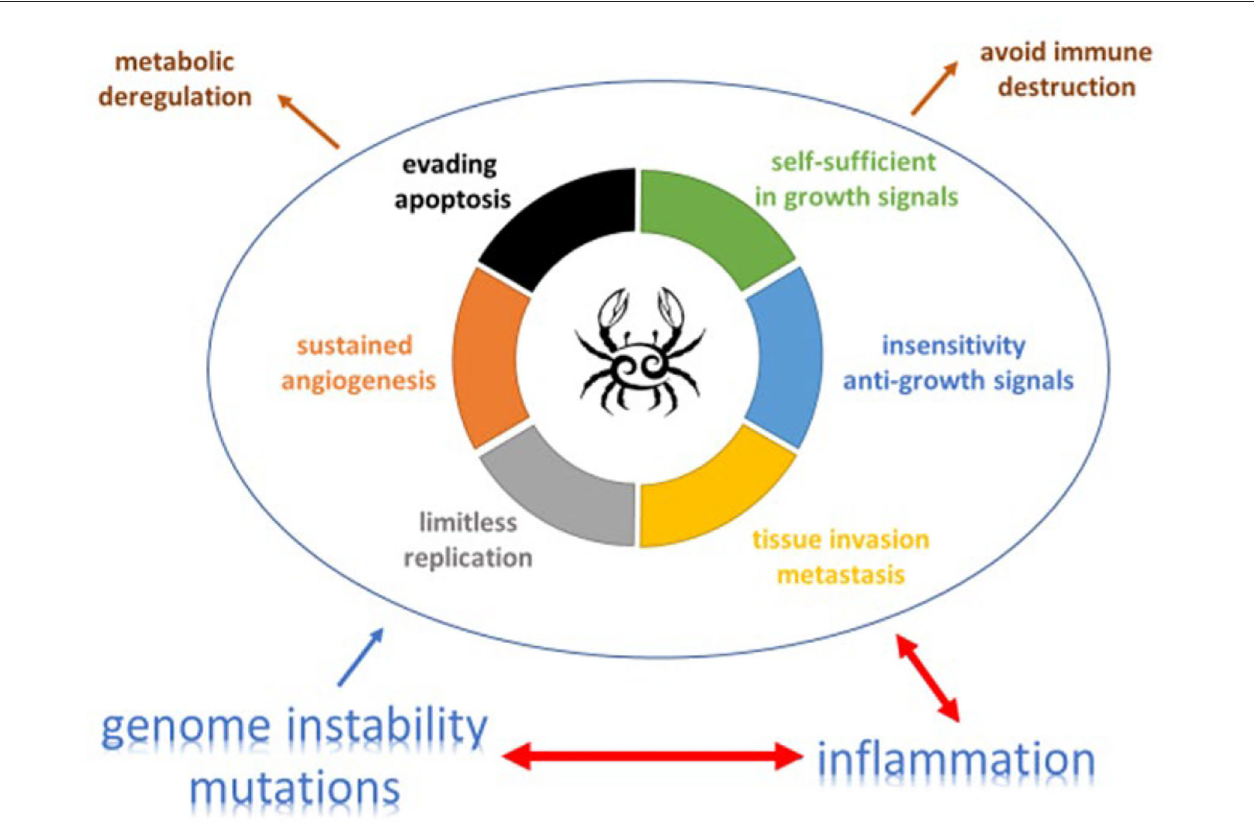
FIGURE 1 | The complex relation and balance between genomic instability, inflammation and cancer promotion and control [adapted from (19) and (20)]. An increasing body of research suggests that two additional hallmarks of cancer are involved in the pathogenesis of some and perhaps all cancers. One involves the capability to modify, or reprogram, cellular metabolism in order to most effectively support neoplastic proliferation. The second allows cancer cells to evade immunological destruction, in particular by T and B lymphocytes, macrophages, and natural killer cells. Additionally, two consequential characteristics (lower half of figure) of neoplasia facilitate acquisition of both core and emerging hallmarks. Genomic instability endows cancer cells with genetic alterations that drive tumor progression. Inflammation by innate immune cells designed to fight infections and heal wounds can instead result in their inadvertent support of multiple